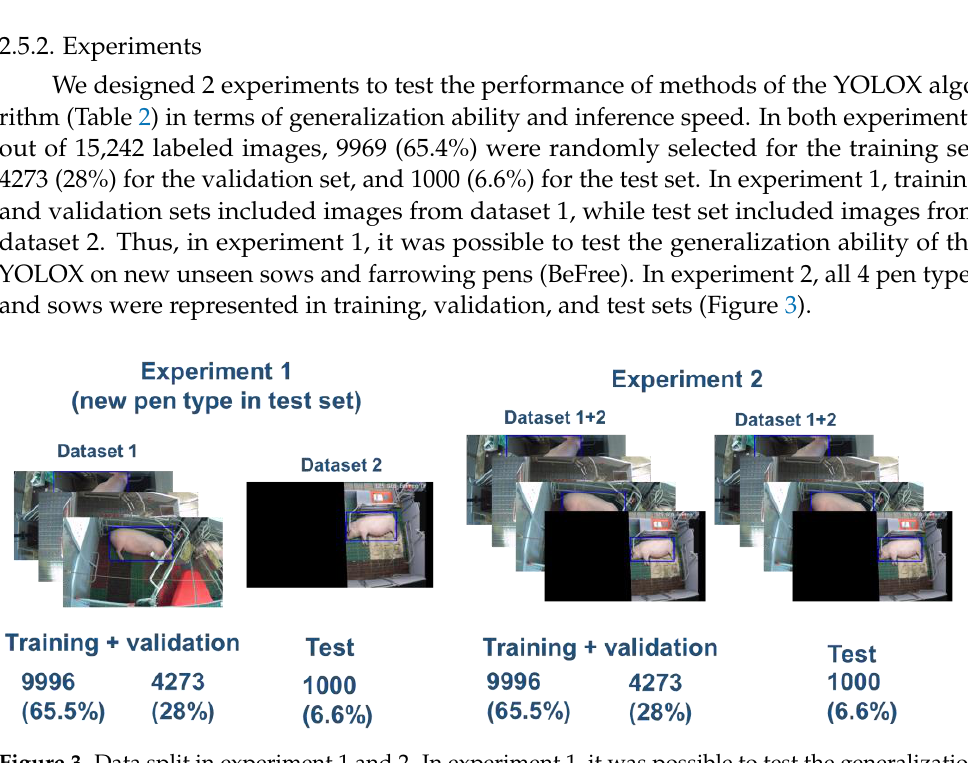
Figure 3. Data split in experiment 1 and 2. In experiment 1, it was possible to test the generalization ability of the YOLOX on new unseen sows and farrowing pens (BeFree). In experiment 2, all 4 pen types and sows were represented in training, validation, and test sets.